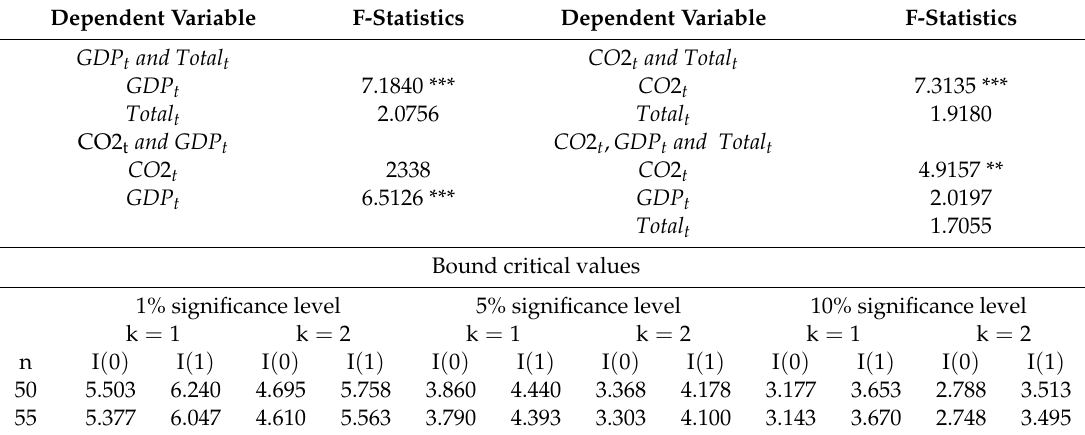
Table 4. ARDL bound test results for GDP t , Total t , and CO 2